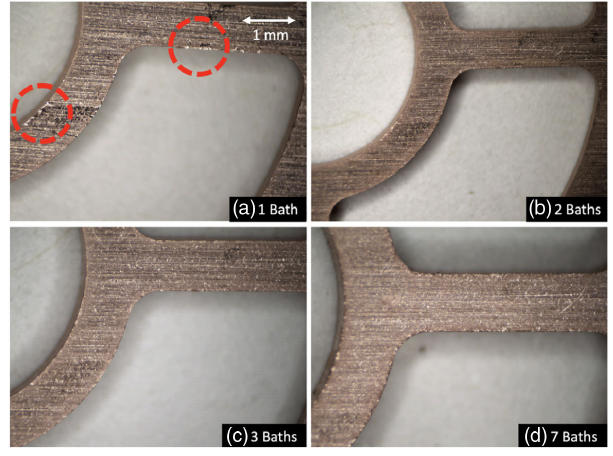
FIG. 26. Comparison of plate surface finish after one, two, three, and seven baths. Surface damage, circled, is clearly visible after a single 2% Citranox bath. While two baths still leave obvious surface defects, plates started to exhibit noticeable pitting after more than four baths (seven bath case is shown for clarity).